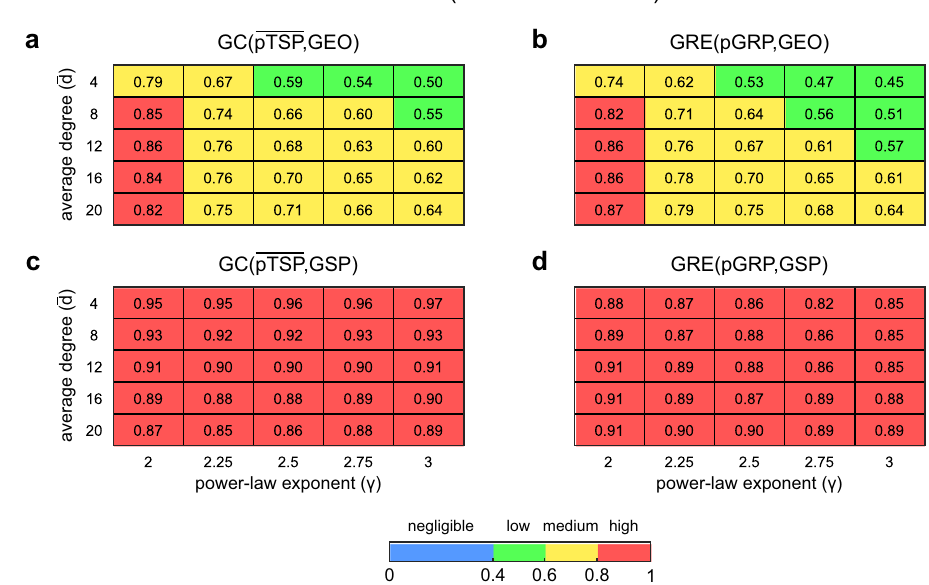
GEO), ( b ) GRE(pGRP, GEO), ( c ) GC(pTSP, GSP) and ( d ) GRE(pGRP, GSP). Each heatmap reports the mean value (over 10 network realizations) of the respective network measure for each combination of (cid:1) d and γ in the nPSO generative